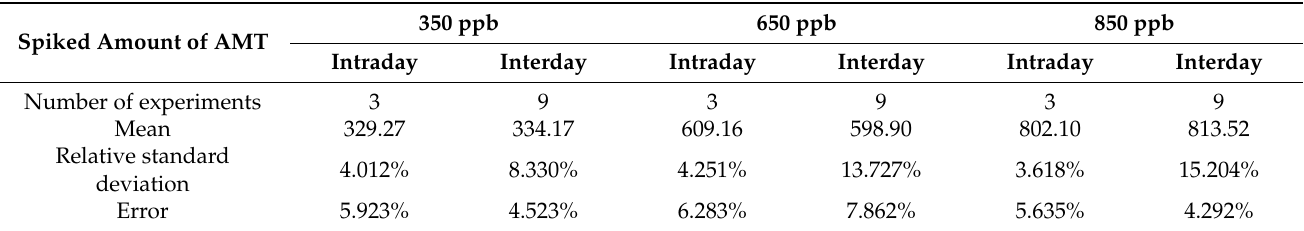
Table 3. Precision and accuracy of controls in dried saliva